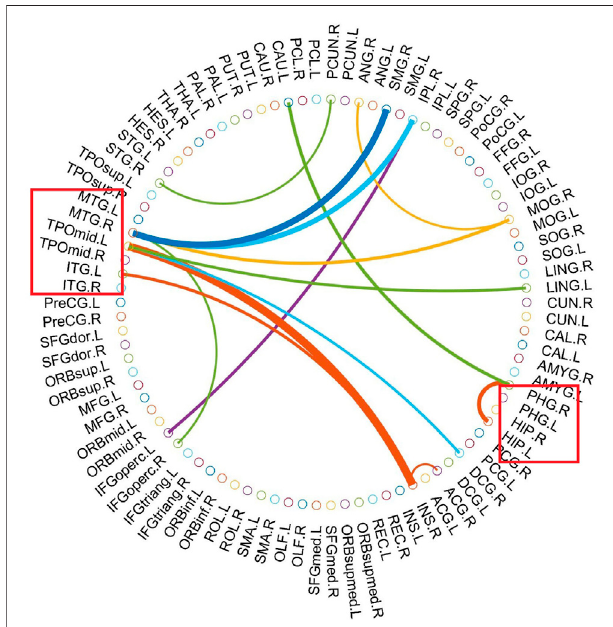
FIGURE 3 | The most consensus connections. The most consensus connections mapped on the International Consortium for Brain Mapping (ICBM) 152 template using the BrainNet Viewer software package http://nitrc. org/projects/bnv/and circularGraph, shared by Paul Kassebaumb http://www.mathworks.com/matlabcentral/ fi leexchange/48576- circulargraph). The red box represents the temporal lobe containment area (HIP,hippocampus;ITG,inferiortemporalgyrus;MTG,middletemporalgyrus; PHG, parahippocampal gyrus; TPOmid, middle temporal gyrus). We selected the consensus connections with a p value < 0.05 in each loop. A total of 45 consensus connections are shown. In exploring the consensus signi fi cant metabolic connections, we observed that the most involved metabolic motor networks were the INS-TPOmid.L, MTG. R-SMG. R, and MTG. R-IPL.R pathways between the seizure recurrence and seizure free groups, and yielded further detailed individual pathological connectivity in the PHG. R-CAU.L, PHG. R-HIP.L, TPOmid.L-LING.R, TPOmid.L-DCG.R, MOG. R-MTG.R, MOG. R-ANG.R, and IPL. R-IFGoperc.L